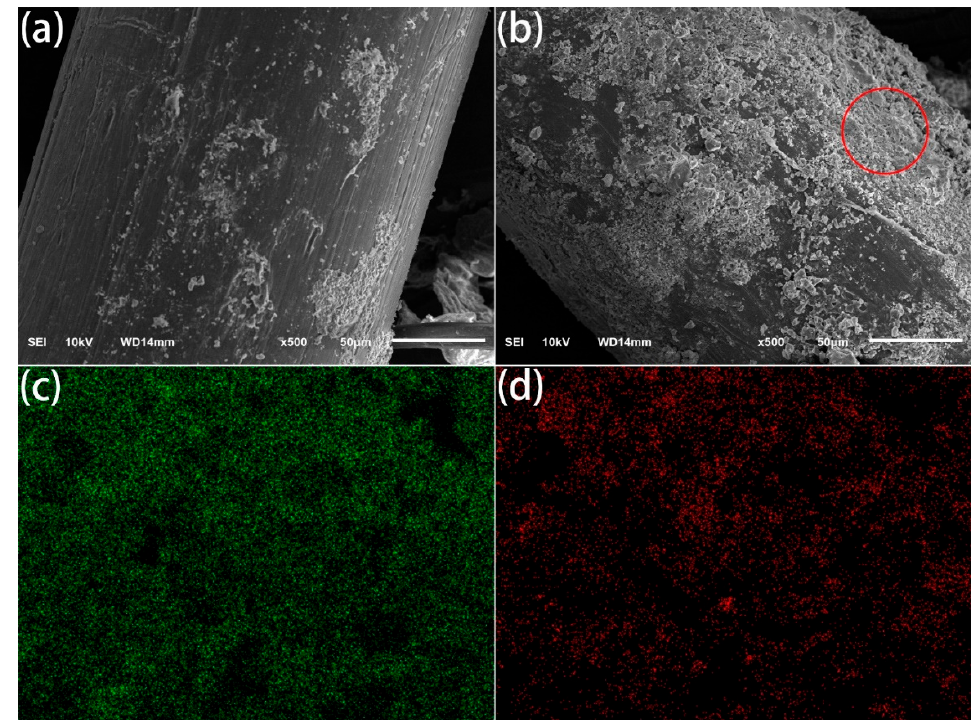
Figure 10. SEM photos of untreated ( a ) and treated for: 180 s ( b ) POM fibers; and EDS images of Ca ( c ) and Mg ( d ).